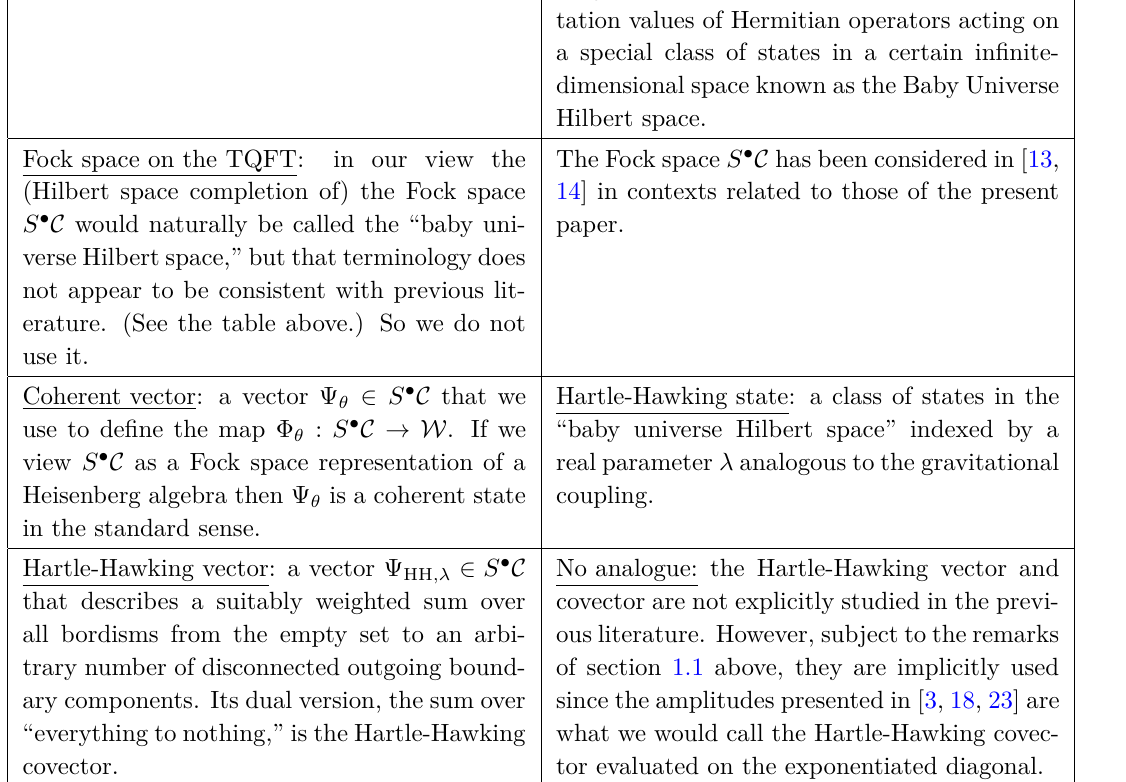
Table 1 . Dictionary between some of the concepts in this paper and in [3, 18,